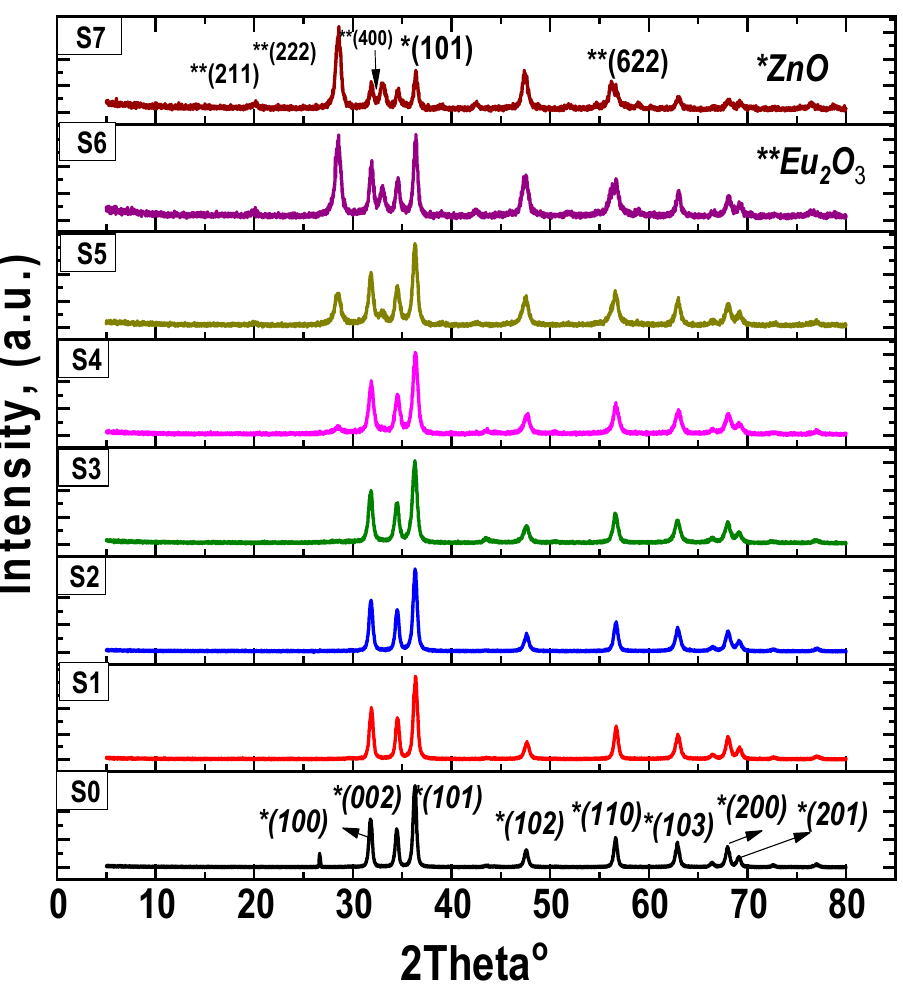
Figure 1. XRD patterns of the prepared Eu 2 O 3 -ZnO nanostructures at different concentrations. * is pure ZnO phase and ** is for Eu 2 O 3 phase. Table 2. The calculated grain size, dislocation, and lattice strain values of all nanostructured Eu 2 O 3 - doped ZnO samples were studied from XRD analysis compared with the SEM results